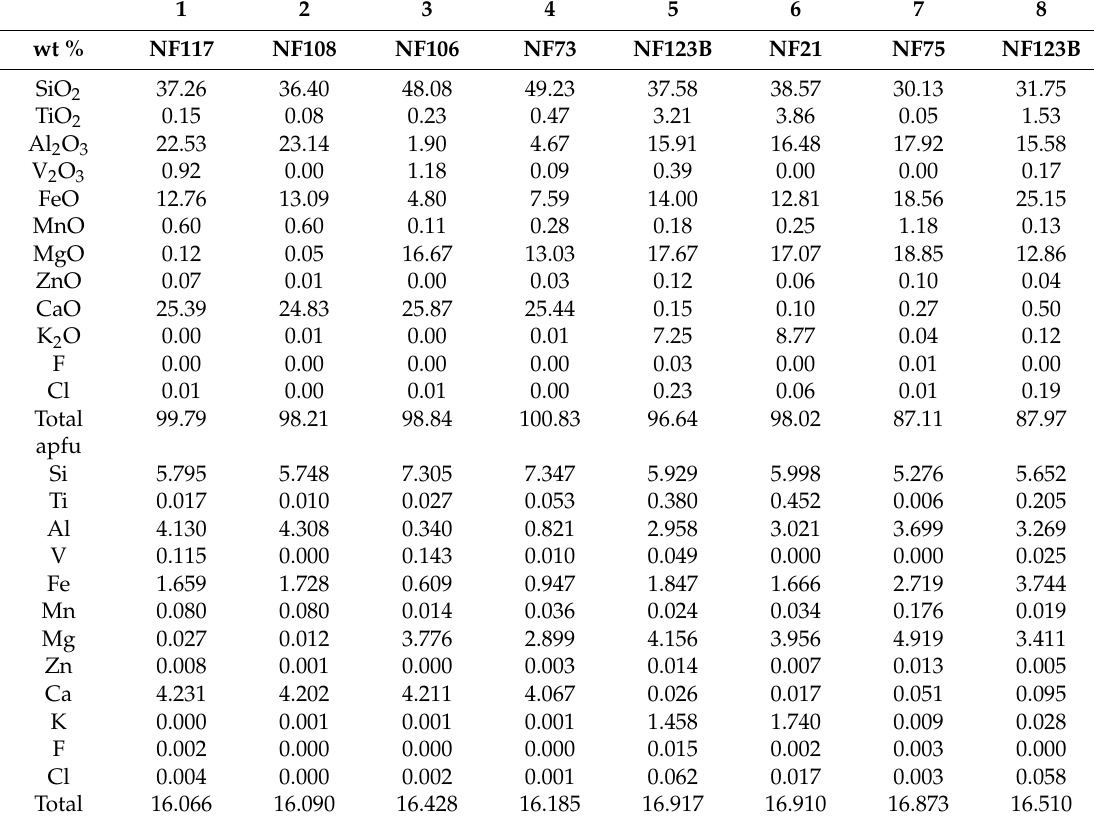
Table 2. Representative electron microprobe analyses of silicates from the Banana Creek